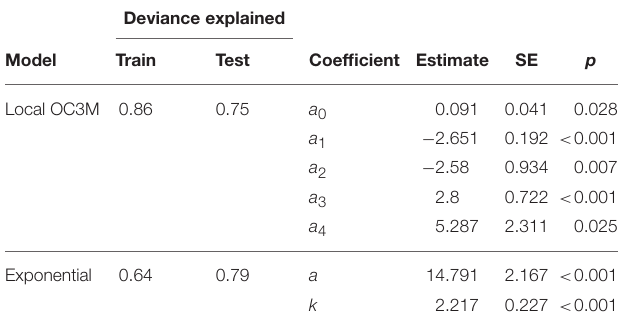
TABLE 4 | Summary of the locally-tuned model outputs for the Hawke Bay water quality information (HAWQi) monitoring buoy for the 6 h averaged